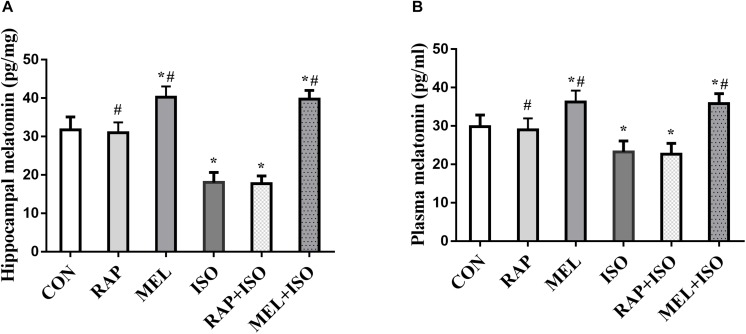
Melatonin reverses isoflurane-induced decrease in hippocampal and plasma melatonin levels. (A,B) Hippocampus and plasma melatonin levels were significantly decreased after isoflurane exposure, with exogenous melatonin (10 mg/kg) markedly reversing the reduction in melatonin levels that occur post-isoflurane exposure. All data are depicted in terms of mean ± SD (n = 12). ∗P < 0.05 versus CON group; #P < 0.05 versus ISO group.